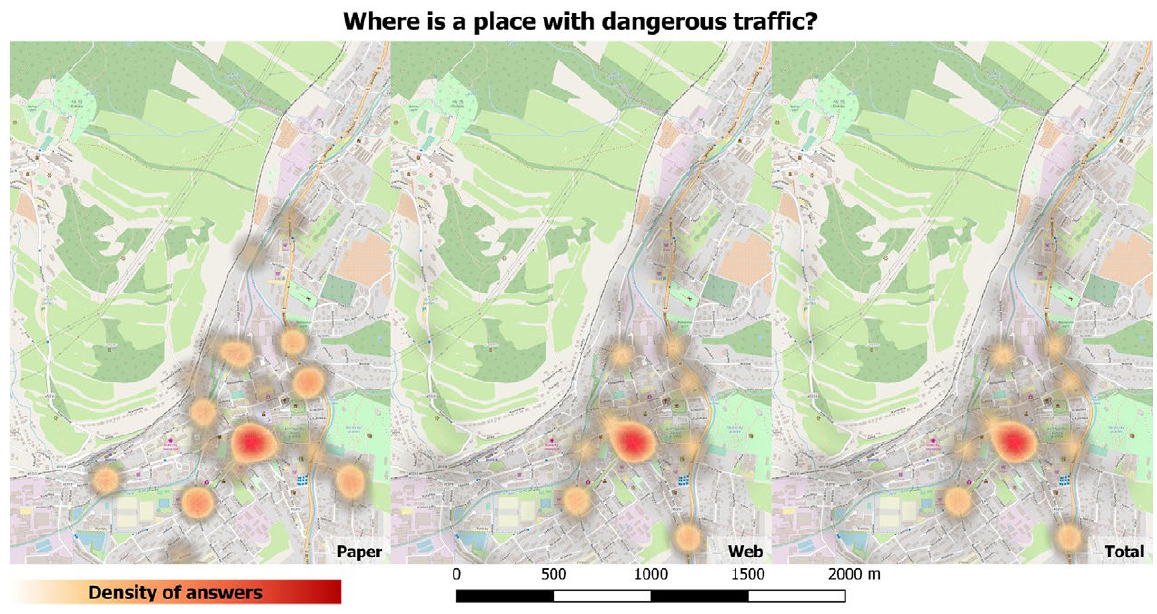
Fig. 7. Where do respondents think it is dangerous, traffic-wise, in